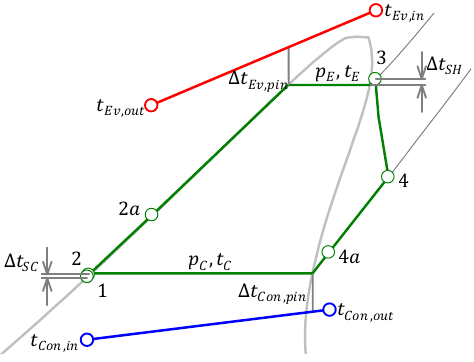
Figure 2. T–s diagram for the organic Rankine